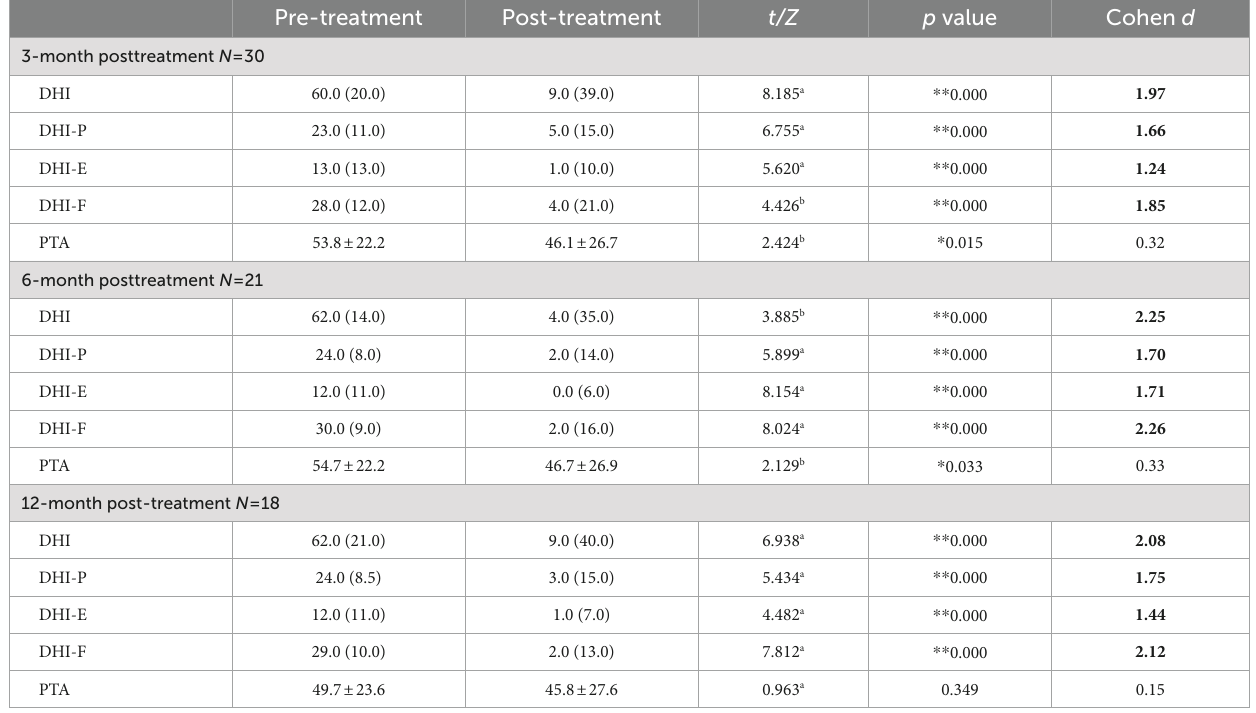
TABLE 3 Comparison of DHI and PTA pre- and post-treatment for MD patients. Pre-treatment Post-treatment t/Z p value Cohen d